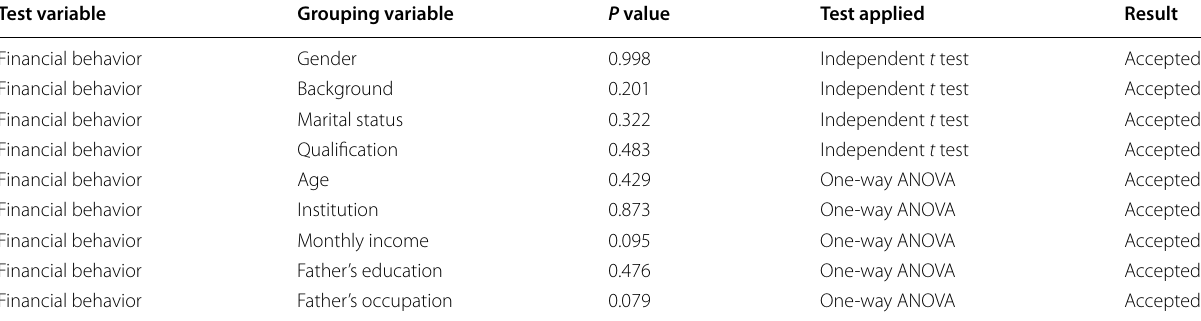
Table 3 Parametric analysis